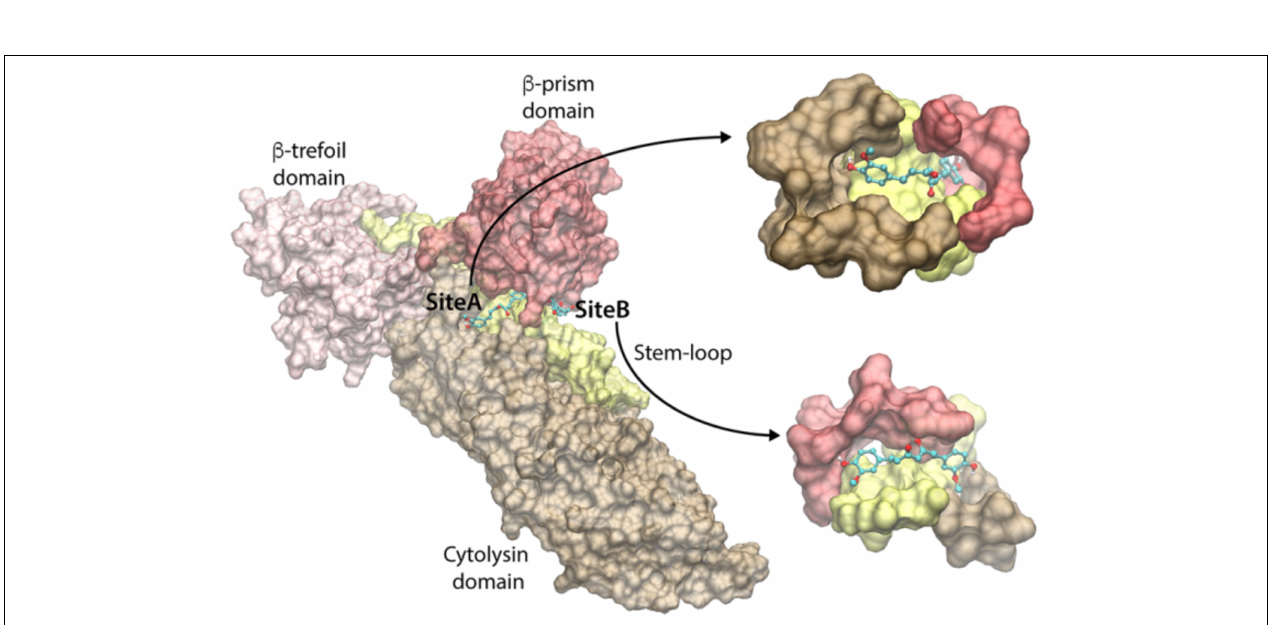
FIGURE 5 | Predicted curcumin-binding sites of VCC. The close-up views of the binding cavities of site-A and site-B are shown with the docked conformation of curcumin. VCC structure is represented by transparent Surf representation. Cytolysin domain, β -trefoil domain, pre-stem motif, and β -prism domain are shown in brown, pink, yellow, and red colors, respectively. The docked curcumin in site-A and site-B is represented as the ball-and-stick model, with carbon, oxygen, and hydrogen atoms shown in cyan, red, and white colors, respectively.